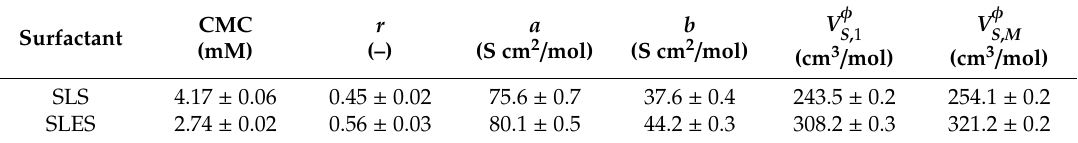
Table 1. The values of the W. Al-Soufi, L. Pi´neiro and M. Novo (APN) model parameters and apparent molar volumes of sodium lauryl sulfate (SLS) and sodium lauryl ether sulfate (SLES) (all given uncertainties correspond to the standard errors of parameters obtained from the fits).